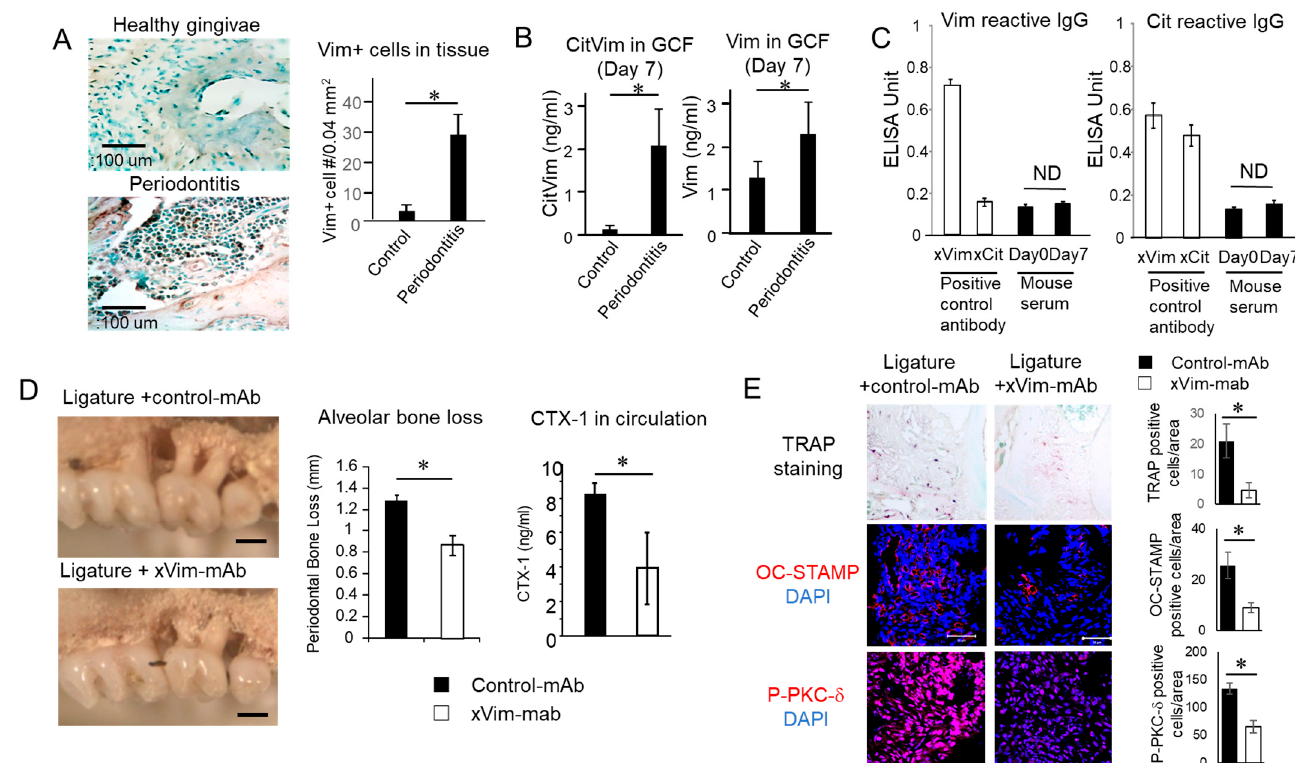
Figure 5. Possible pathogenic engagement of CV in the onset of periodontitis induced in mice. To monitor the expression pattern of CV and possible inhibitory effect of anti-vim mAb, a mouse model of ligature-induced periodontitis was employed ( n = 5/group). ( A ) Expression of vimentin in periodontal lesion induced by ligation was visualized by immunohistochemistry. Infiltration of vimentin-positive cells was measured. ( B ) Expression of vimentin or CV in mice GCF was detected by ELISA, as described above. ( C ) Detection of anti-vimentin and anti-citrulline antibodies in murine serum. ( D ) Alveolar bone resorption around maxillary second molars induced by ligation for 7 days with injection of anti-vimentin mAb or control IgG was microscopically measured. CTX-1 concen- tration in serum of ligatured mice with injection of anti-vimentin mAb or control IgM was analyzed by ELISA. ( E ) Presence of TRAP-, OC-STAMP- or Phospho-PKC- δ -positive cells in the tissue section of mice induced with periodontitis is shown. Results are shown as means ± SD. * p < 0.05.